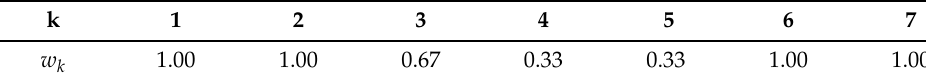
Table 3. Weights used in Equation